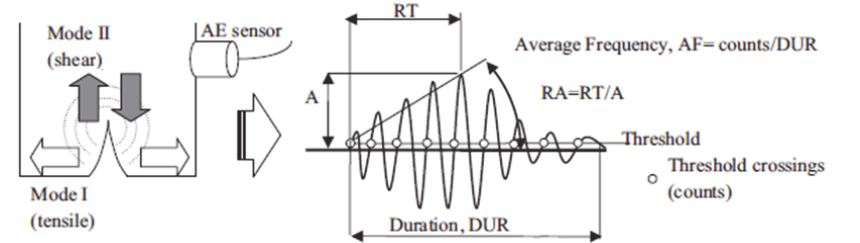
Figure 4: Cracking modes and typical acoustic emission signals [12].